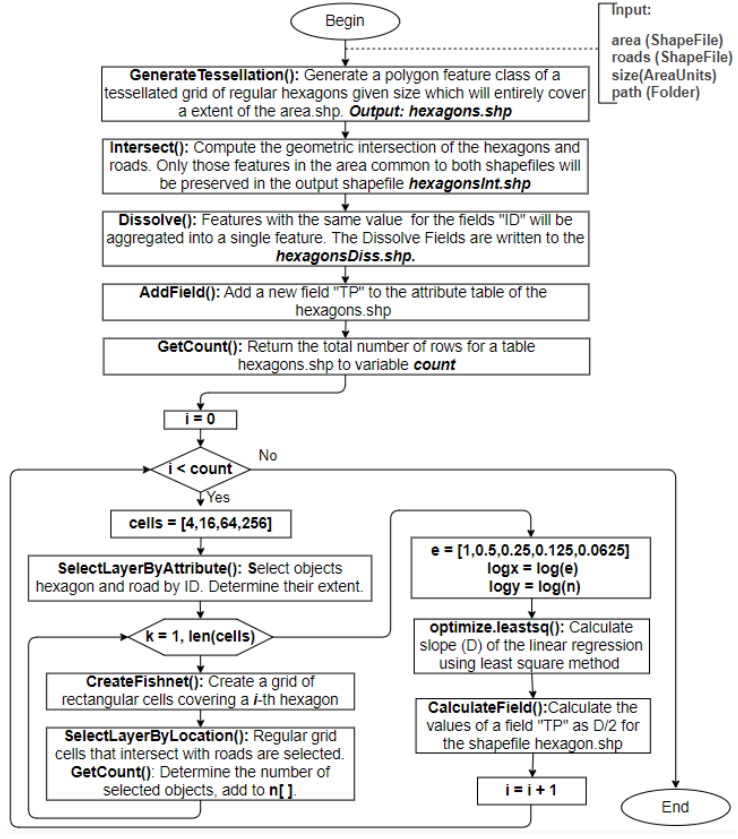
Figure 8. Python script algorithm.